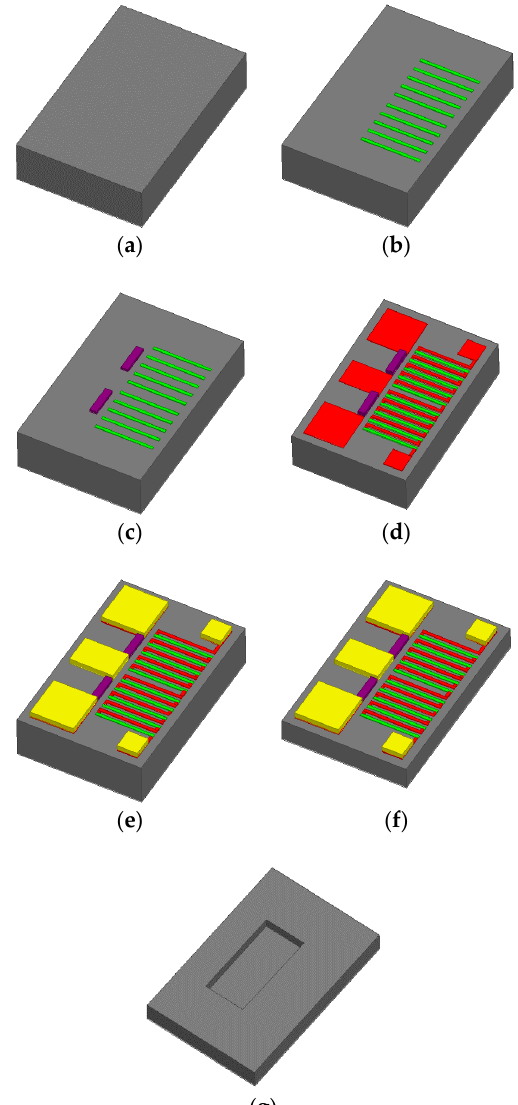
Figure 8. Fabrication process of the power sensor by GaAs MMIC technology (Steps (a)–(g) in Section 4).